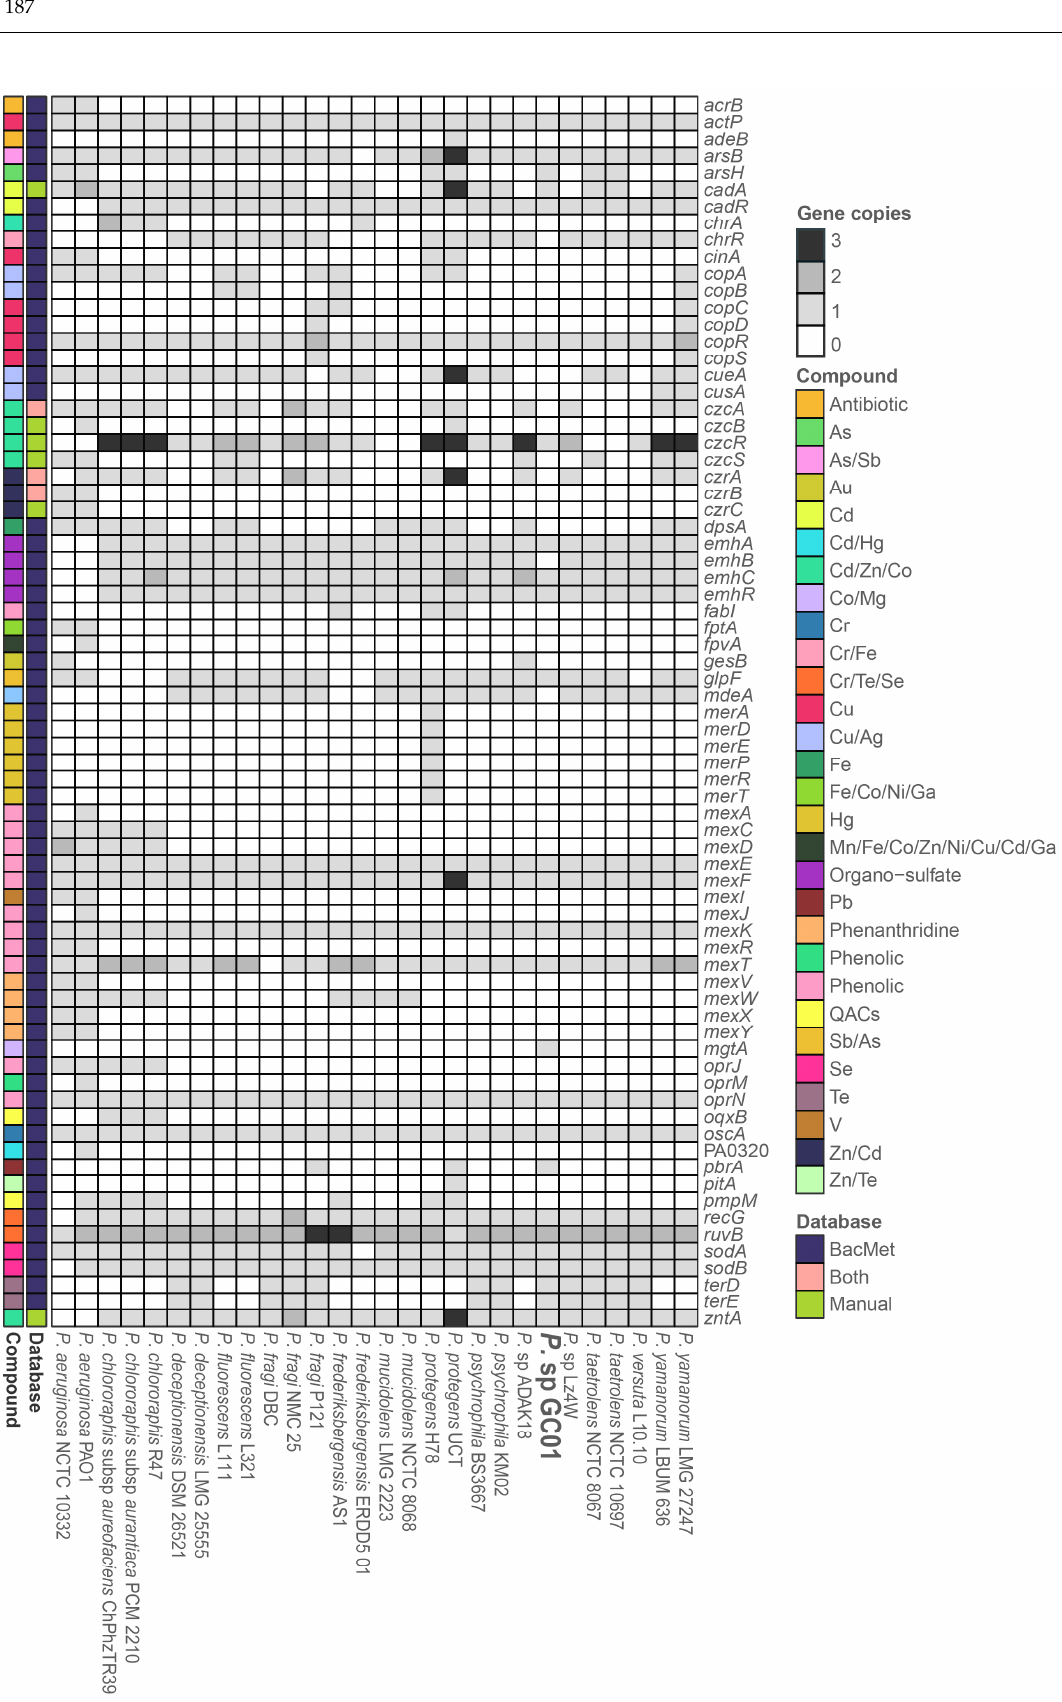
Figure 4. Heatmap of the metal-resistance genes present on the 28 Pseudomonas genomes. The scale shows the copy number of each gene in the corresponding genome, the metal(loid)/compound associated with the gene, and the database